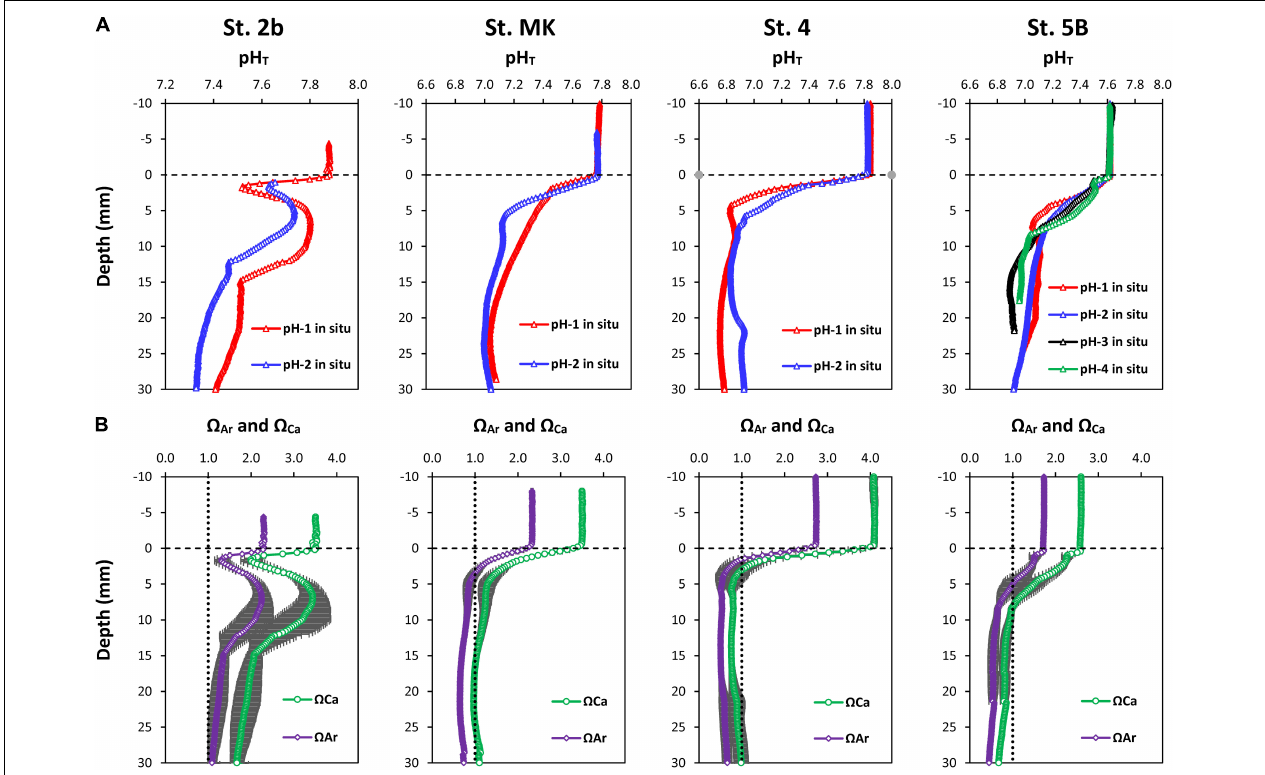
FIGURE 5 | (A) Replicate pH micro-profiles obtained in situ at the sediment-water interface of the Louisiana shelf in July-August 2017. (B) Calcium carbonate saturation state with respect to calcite and aragonite with their uncertainties calculated for each station from the average pH micro-profile and interpolated TA profile using the CO2SYS program (see text for details). The vertical dashed line represents saturation with calcite or aragonite.